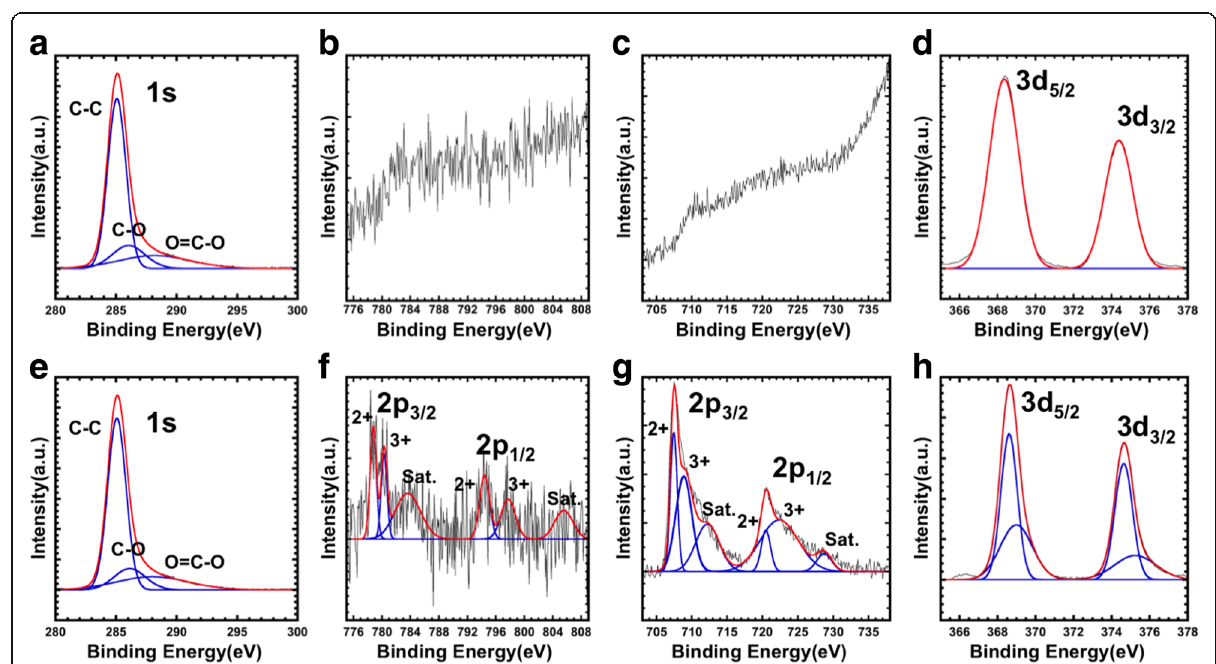
derived from C-O-C was observed, which is derived from oleic acid modified on the surface. While the peaks of Ag(3d) were observed, those of Fe(2p) and Co(2p) could not be observed, indicating that the core was completely covered with the Ag shells (Fig. 3b – d). On the other hand, the peaks of Fe(2p) and Co(2p) were observed in the nanoparticles after the etching operation with argon ion (Fig. 3f, g). The peaks of Fe(2p) and Co(2p) are decomposed and can be assigned